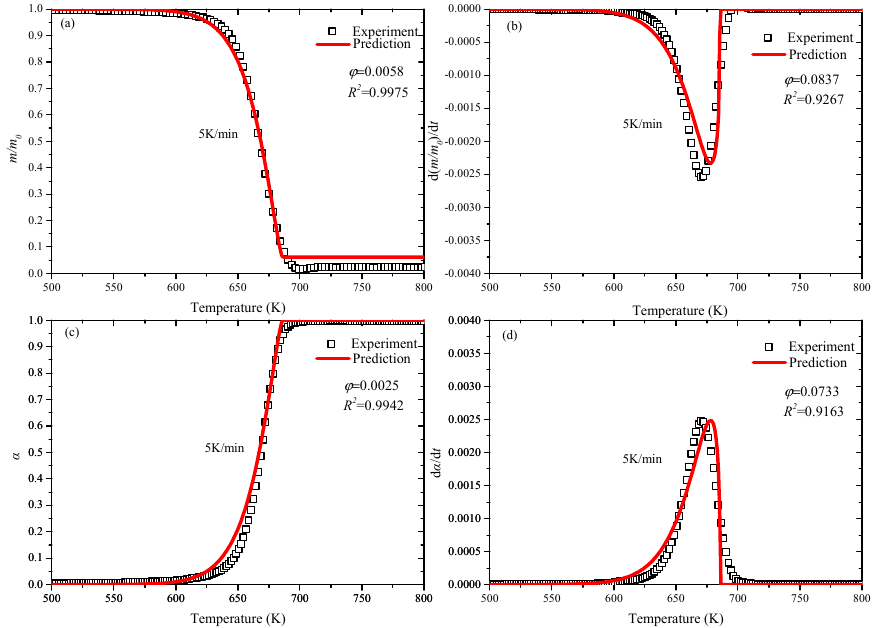
Figure 3. Predicted and experimental curves in nitrogen at 5K/min: ( a ) m/m 0 ; ( b ) d(m/m 0 )/dt ; ( c ) α ; ( d ) d α /dt .